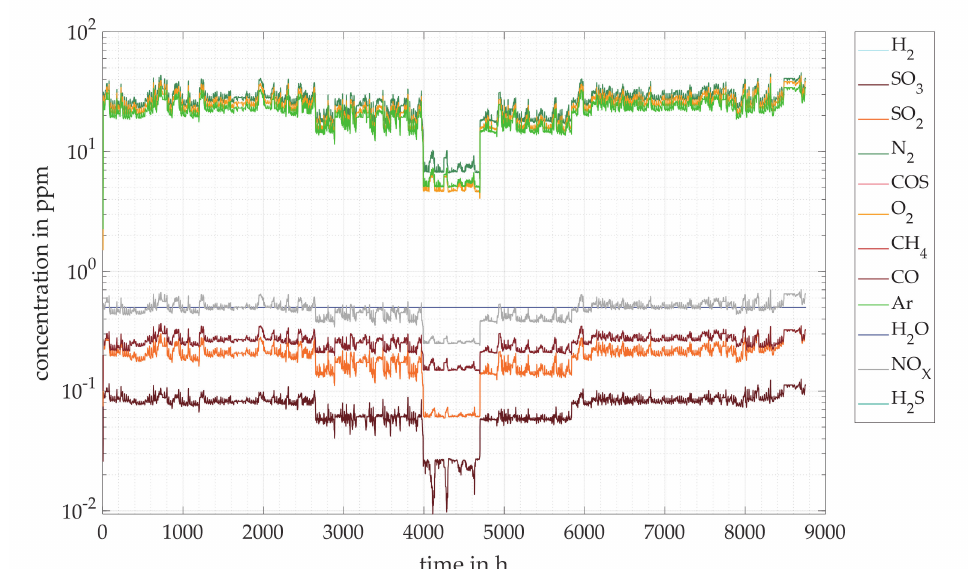
Figure 8. Simulated variation (hourly averages) of individual impurity concentrations at the entry of the trunk pipeline throughout one year ( = 8760 h) for the scenario “No lignite” (T = 288 K, p inlet ≤ 12.62 MPa; note that COS concentration data are hidden behind the H 2 S data as its concentration values are identical to those of H 2 S throughout the